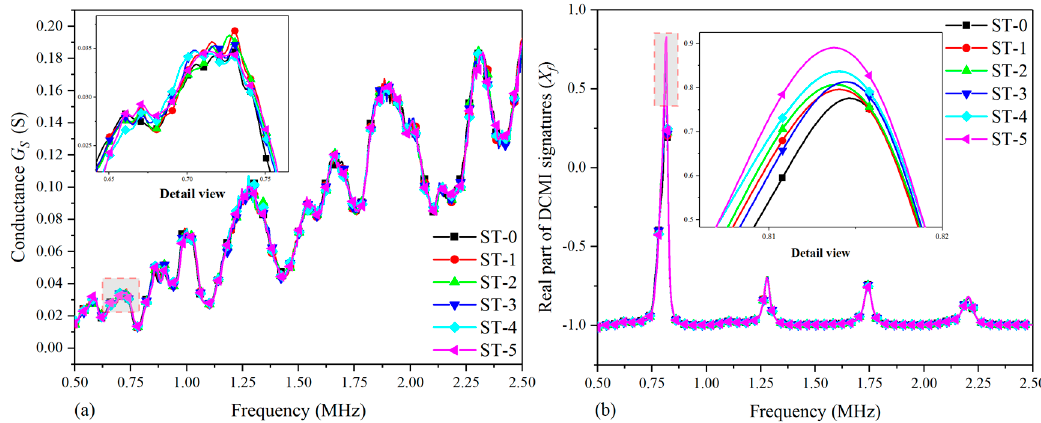
Figure 13. Comparative plots based on real part of signatures for fuselage: ( a ) raw conductance signatures G s , ( b ) extracted DCMI signatures X f .